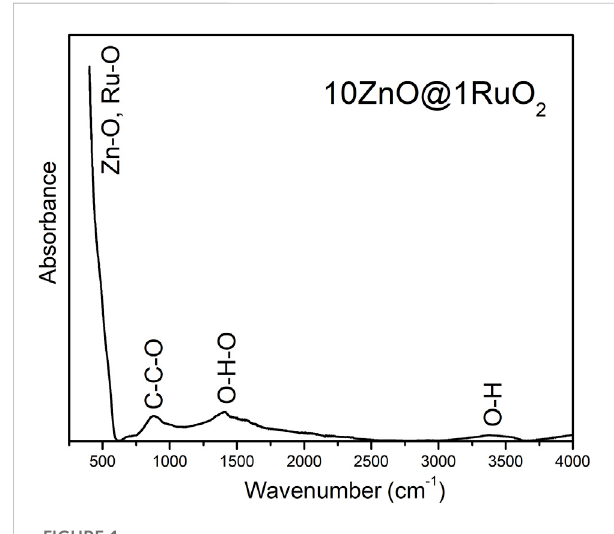
FIGURE 1 FTIR spectrum of pristine 10ZnO@1RuO 2